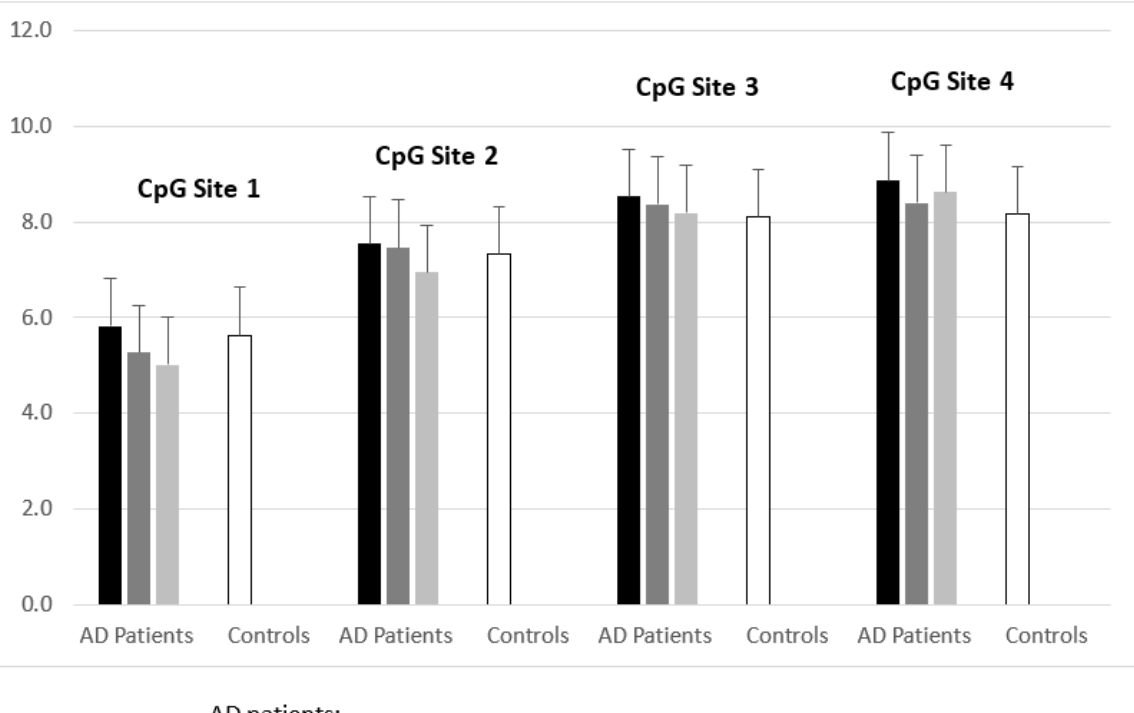
Figure 2. GABRA2 CpG Site Methylation in Alcohol-Dependent Individuals vs. Control Subjects Across Measurements (Mean + SD). 3.3. Comparison of GABRA2 CpG Methylation Sites over Time in AD